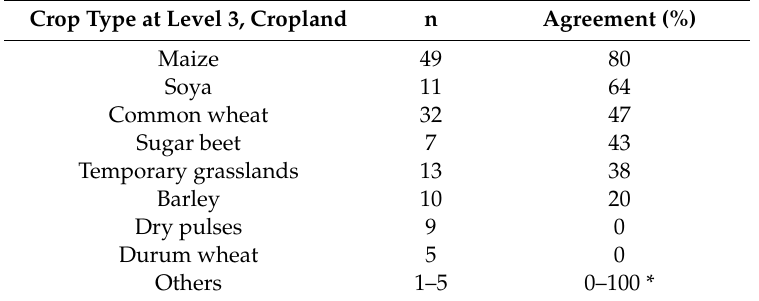
Table 6. Percent agreement in the main LC class Cropland by crop type. The data are sorted according to percentage of agreement in descending order.